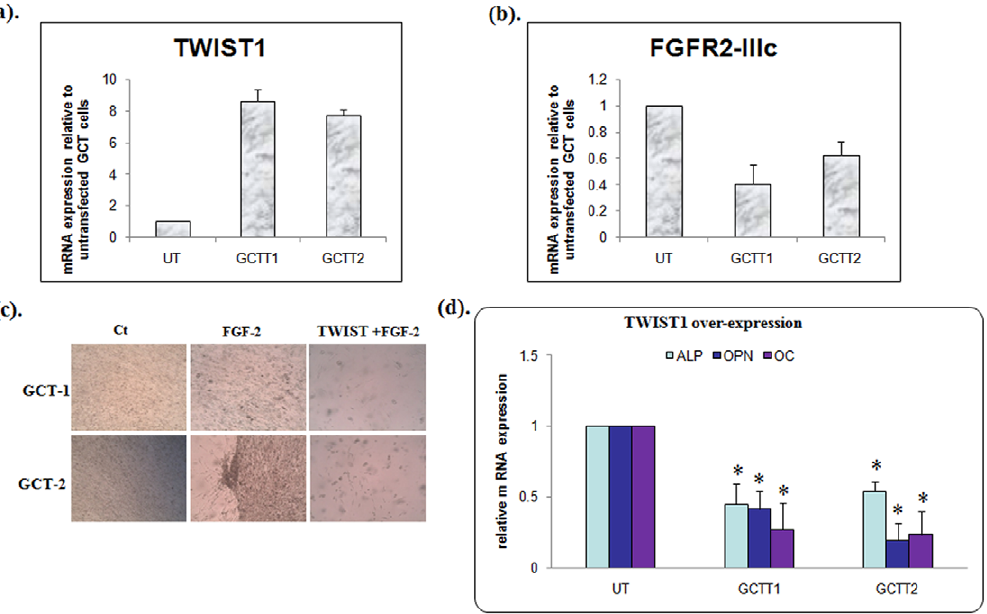
Figure 5. TWIST1 suppresses osteogenic differentiation. ( a ). Quantitative RT-PCR analysis representing higher TWIST1 expression in transfected GCTT1, GCTT2 cells compared to untransfected (UT) GCT stromal cells. ( b ). Quantitative PCR analysis showing a 60% decrease of FGFR2- IIIc expression in GCTT1 and a 50% decrease of FGFR2-IIIc expression in GCTT2 stromal cells (*p , 0.05). ( c ). GCT cells were transfected with TWIST1 and matrix mineralization compared to control (CT) and FGF-2 treated GCT cells. ( d ). TWIST1 over-expression showed a significant decrease in ALP, OPN and OC mRNA levels in GCT cells treated with FGF-2 (GCTT1, and GCTT2,) when compared to the GCT untreated (UT) FGF-2 cells.